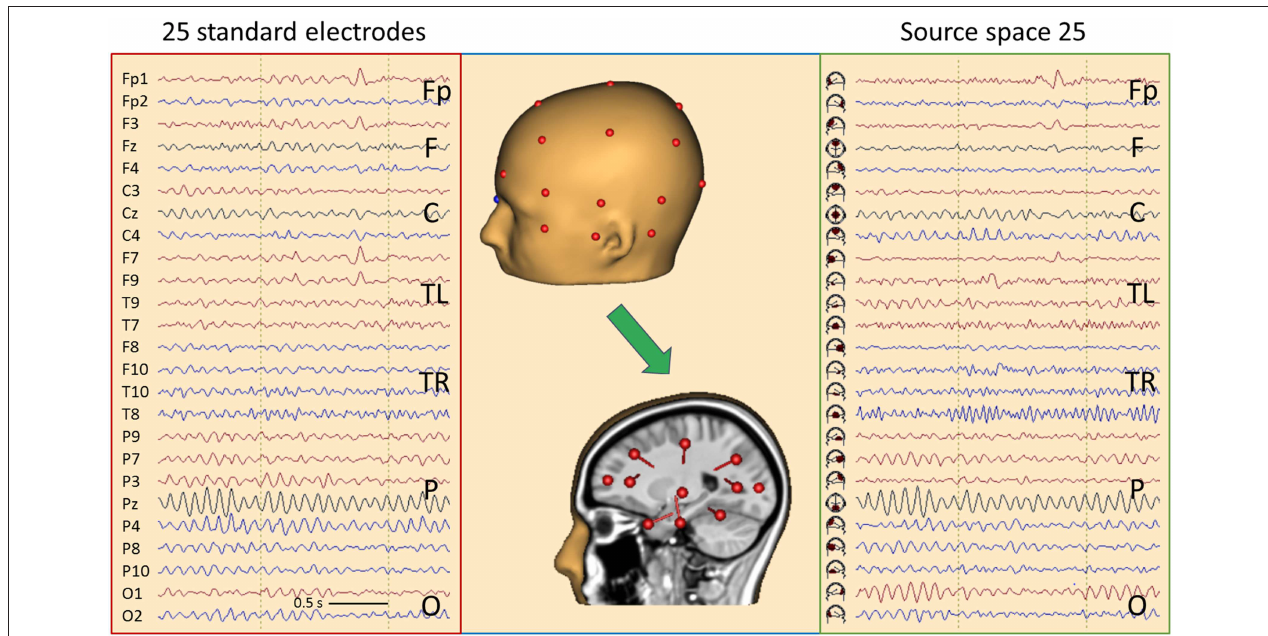
FIGURE 10 | Comparison of the scalp EEG at 25 standard electrodes in average reference ( left ) with standard source space 25 ( right ) using the same sequence of channels in a case with left frontal cortical dysplasia ( 25). Filter settings optimized for IED review: 2–35Hz, zero-phase characteristic (26). A spike is seen in second 2, appearing more focal in source space. In addition, the spread of central µ -rhythm onto frontal channels is greatly reduced in source space, making the frontal spike stand out more clearly. In the center the underlying principle of “taking the EEG back into the brain” is illustrated showing the electrodes on the one hand and the underlying source dipoles on the other. For more details see